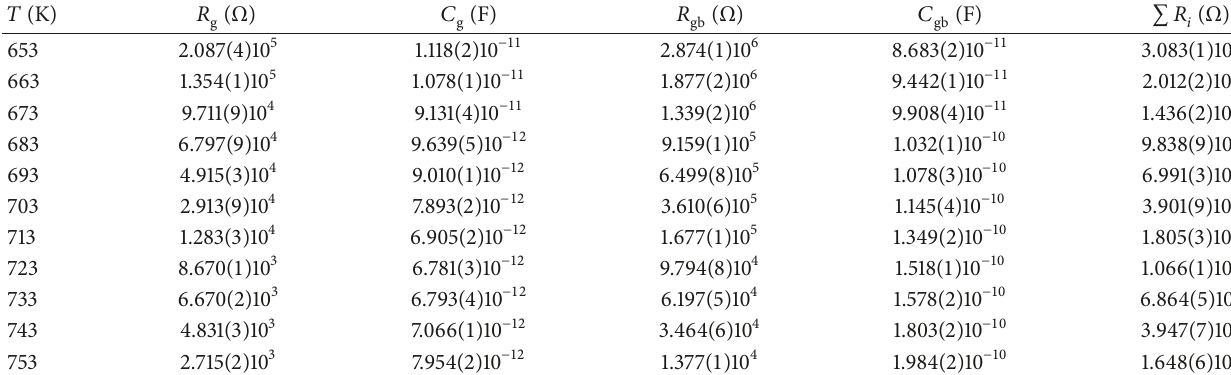
Table 1: Simulated data of the electrical parameters for the proposed equivalent